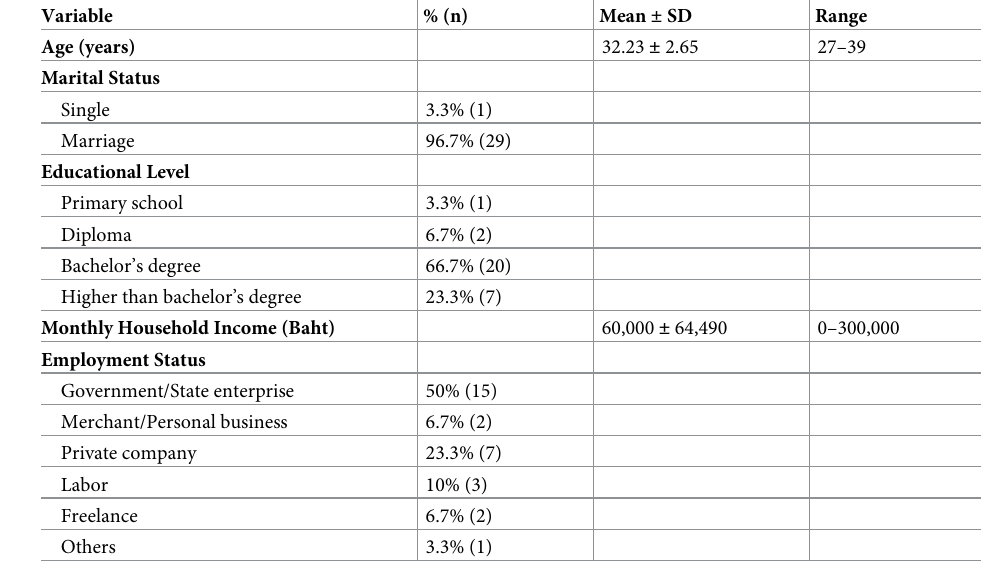
measures. The T-IFI scores had left-skewed distribution. Outliers were found from ones with higher income and those with lower T-IFI score. Table 2. Participant characteristics (n =